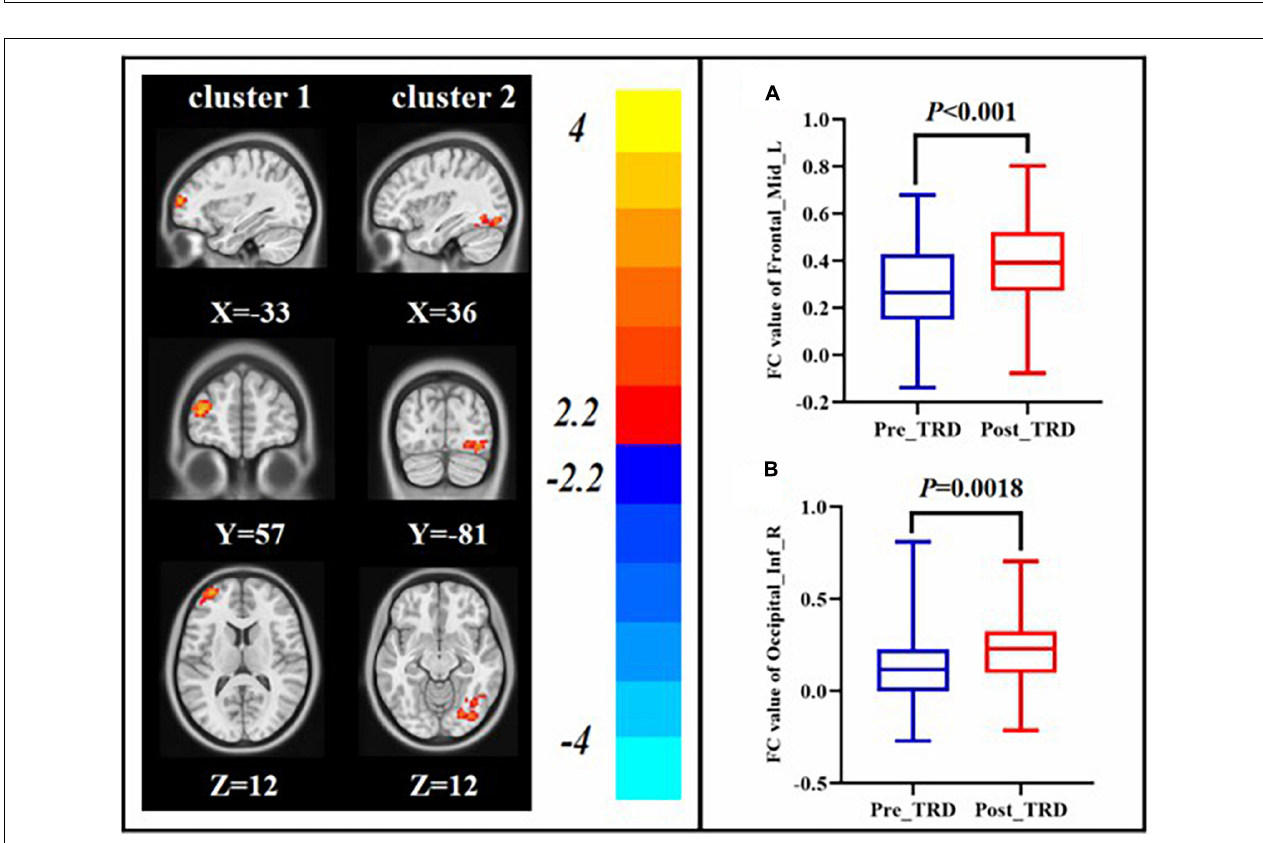
FIGURE 5 | Changes in FC between the post-treatment and pre-treatment. FC value of left middle frontal gyrus (A ), right inferior occipital gyrus (B) .